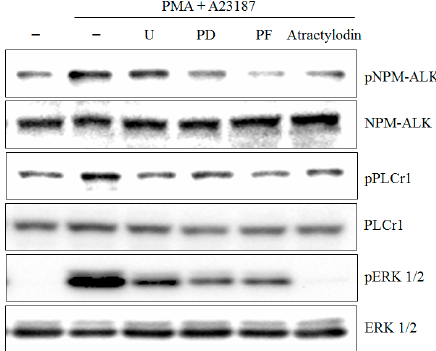
Figure 5. Effect of inhibitors on PMA plus A23187 induced NPM-ALK, PLC γ 1, and ERK phosphorylation in HMC-1. HMC-1 were treated for 0.5 h in the presence or absence of 1 μ M U73122 (U) or 1 μ M PD98059 (PD), or 1 μ M PF-02341066 (PF), or 4 μ M atractylodin and then stimulated for 0.5 h with or without PMA plus A23187 in the continued presence or absence of inhibitors. Whole cell lysates were then analyzed by Western